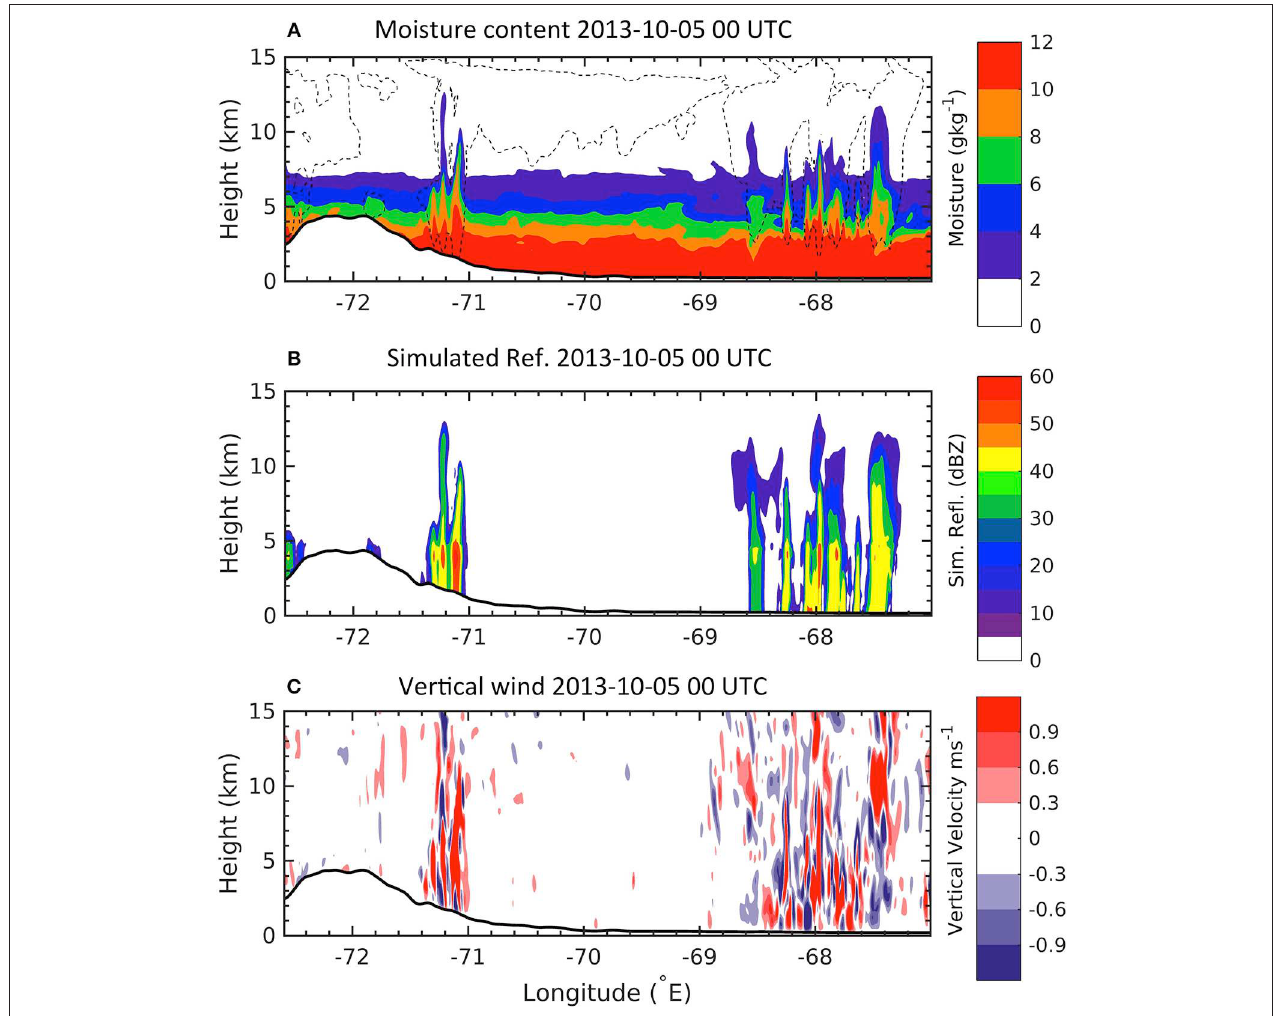
FIGURE 8 | Cross section of (A) moisture content and frozen hydrometeors (B) simulated reflectivity and (C) vertical velocities at 2013-10-05 00:00 UTC. The dashed contour lines in (A) show the 3 × 10 − 3 gkg − 1 value of frozen phases. The cross section is shown in Figure 7A with cyan line at 13.16 ◦ S